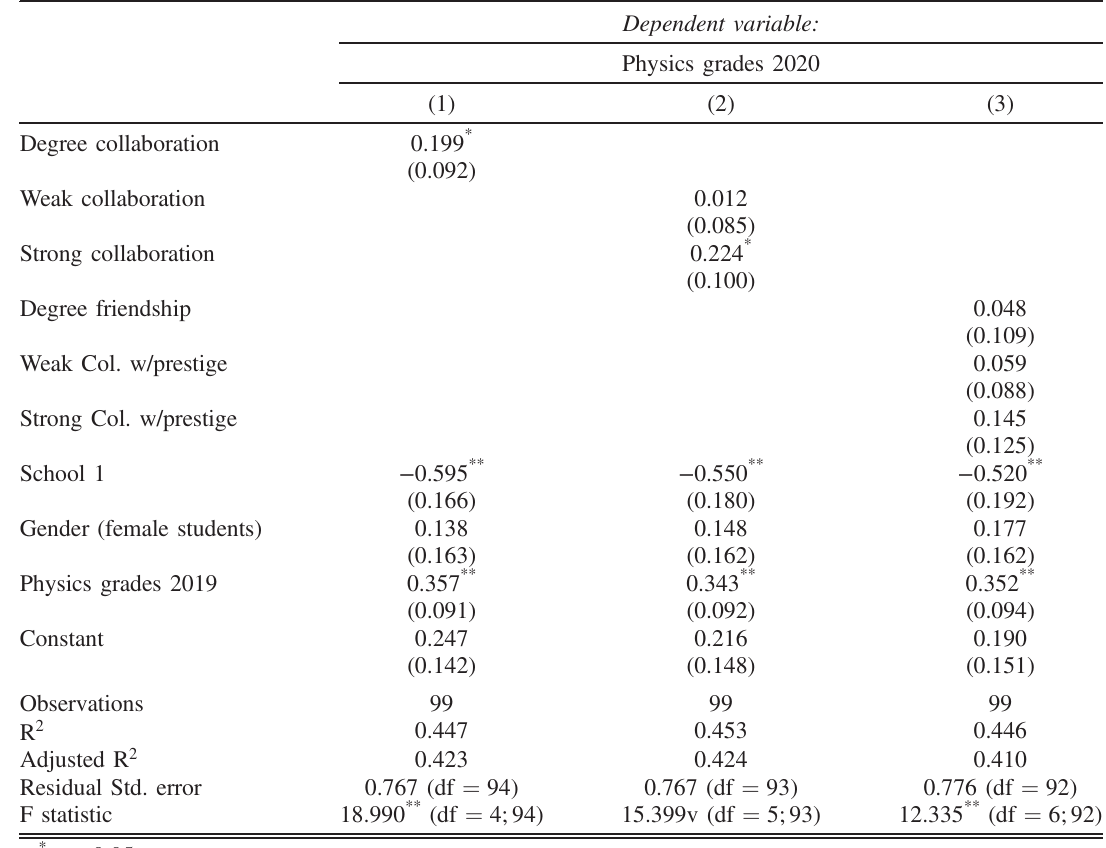
TABLE VII. OLS multiple linear regression models for physics grades regressed on collaborative variables, controlling for confounding variables.